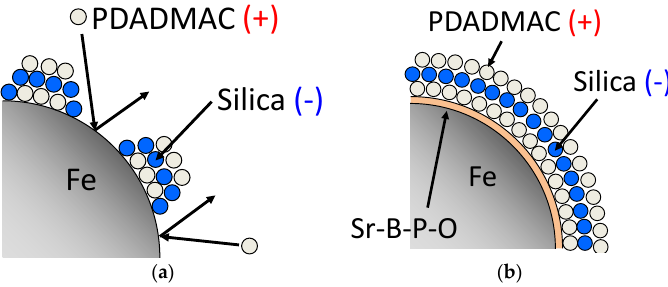
Figure 4. Schematic models for the silica coating of iron powder particles by the lbl method ( a ) without; and ( b ) with Sr-B-P-O insulating layers.